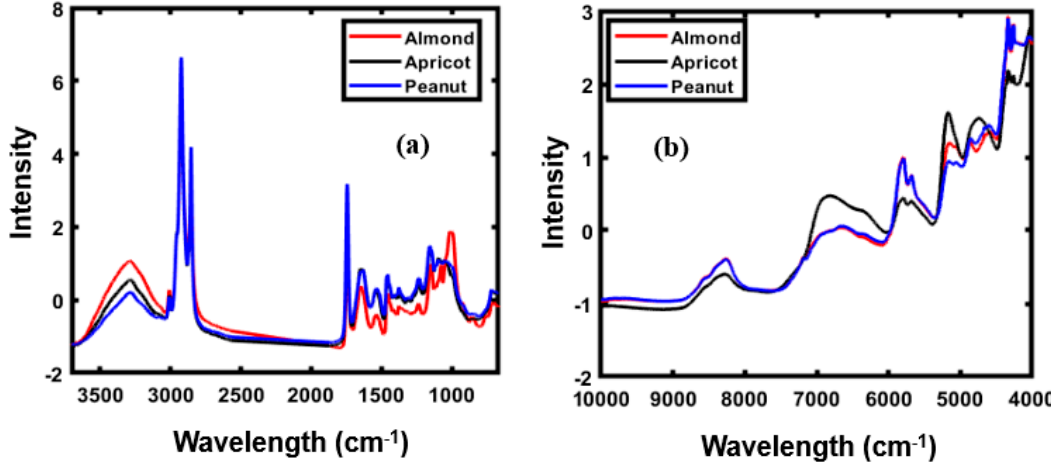
Figure 2. FT-IR ( a ) and FT-NIR ( b ) spectra of almond, apricot, and peanut.